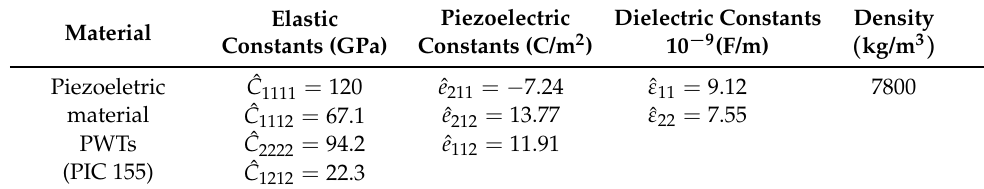
Table 2. Material properties of